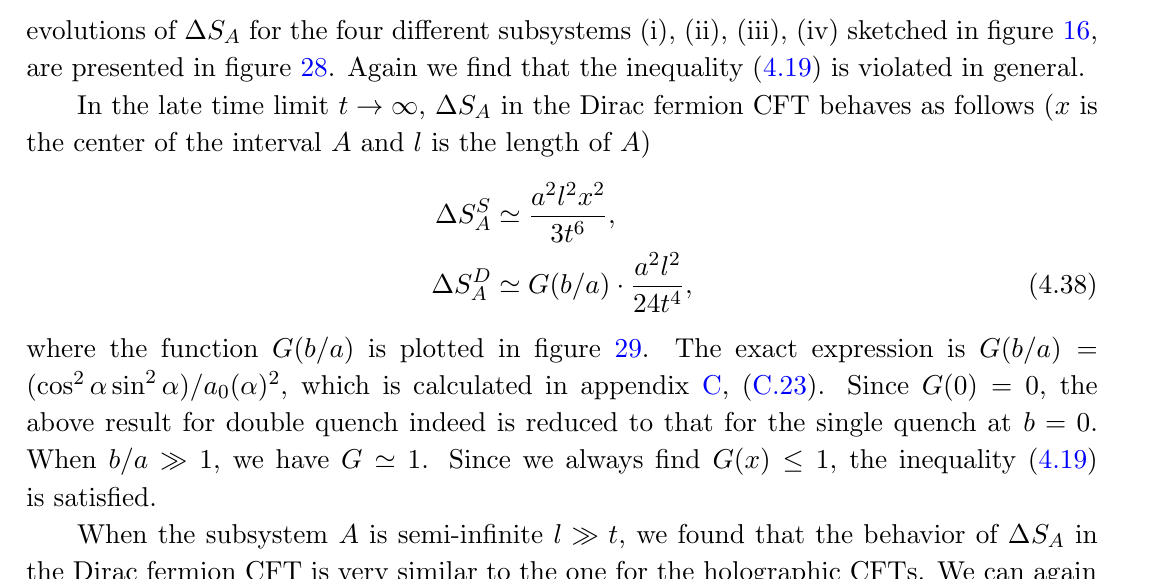
1 ; x +1] and (cid:0)